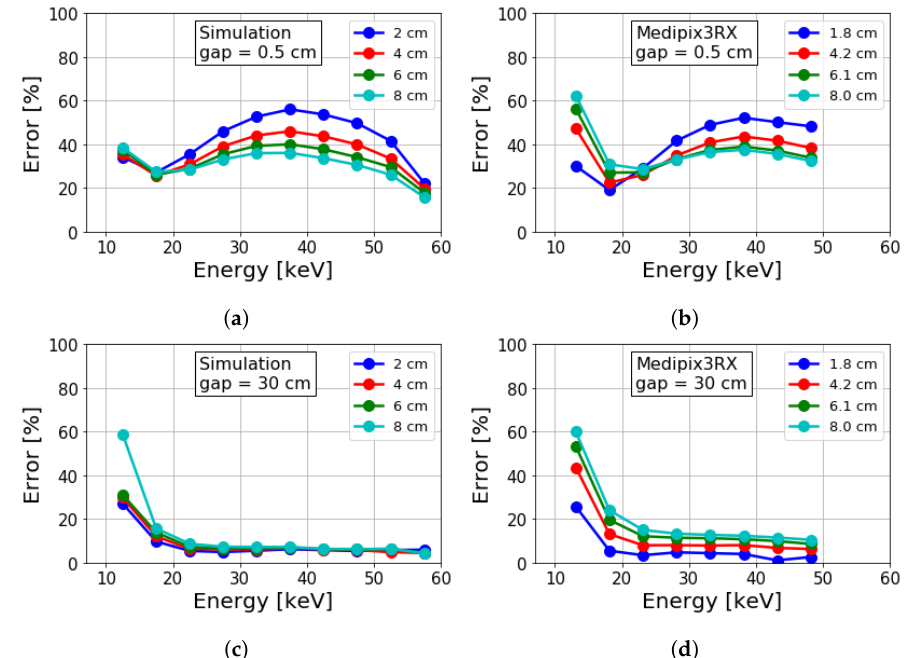
Figure 7. Percent error of estimated attenuation coefficient via simulations (left column) and experiments (right column) for varying energies. Shown for different object thicknesses and air gaps of ( a , b ) 0.5 and ( c , d ) 30 cm,